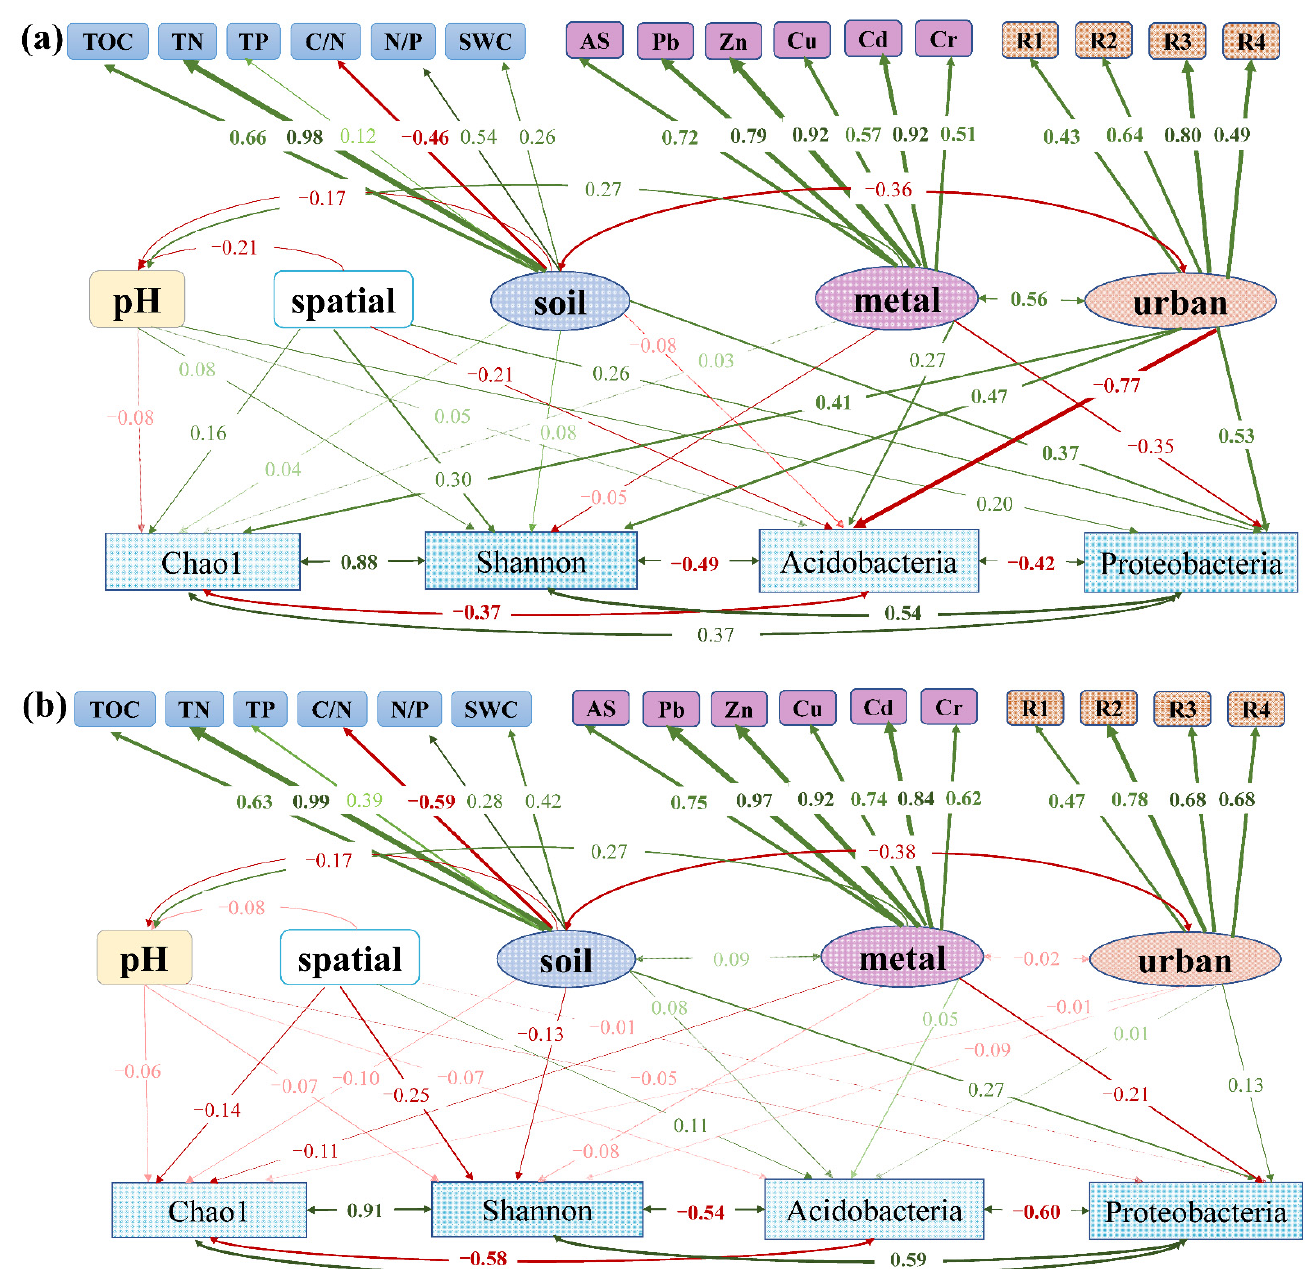
Figure 5. Structural equation model (SEM) of soil environmental factors effects on bacterial diversity and dominant group abundance in forestland ( a ) and grassland ( b ). Green and red arrows represent positive and negative effects, respectively, with the thickness indicating the extent of influence. Values associated with the arrows represent standardized path coefficients. Spatial, spatial variables; soil, soil nutrients; metal, soil heavy metals; urban, urbanization intensity; Acidobacteria, relative abundance of Acidobacteria; Proteobacteria, relative abundance of Acidobacteria; R1, R2, R3, and R4 represent the 250 m, 1 km, 2 km, and 5 km resolutions in the calculation of urbanization intensity, respectively.